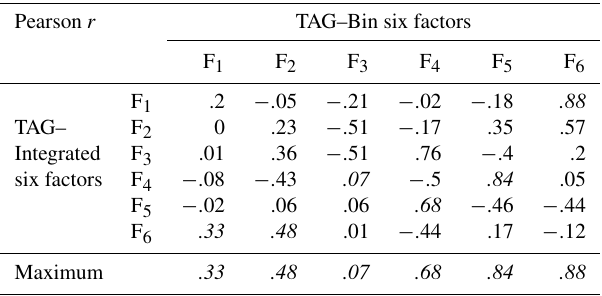
Table 4. The correlation coefficient r of factors’ time series of the PMF six-factor solution between TAG–Bin and TAG–Integrated. TAG–Integrated indicates the TAG integration method. TAG–Bin indicates the TAG binning method for source apportionment. A bin width of five scan points with retention time shift correction is used here. The italic font represents the maximum value in each column. Pearson